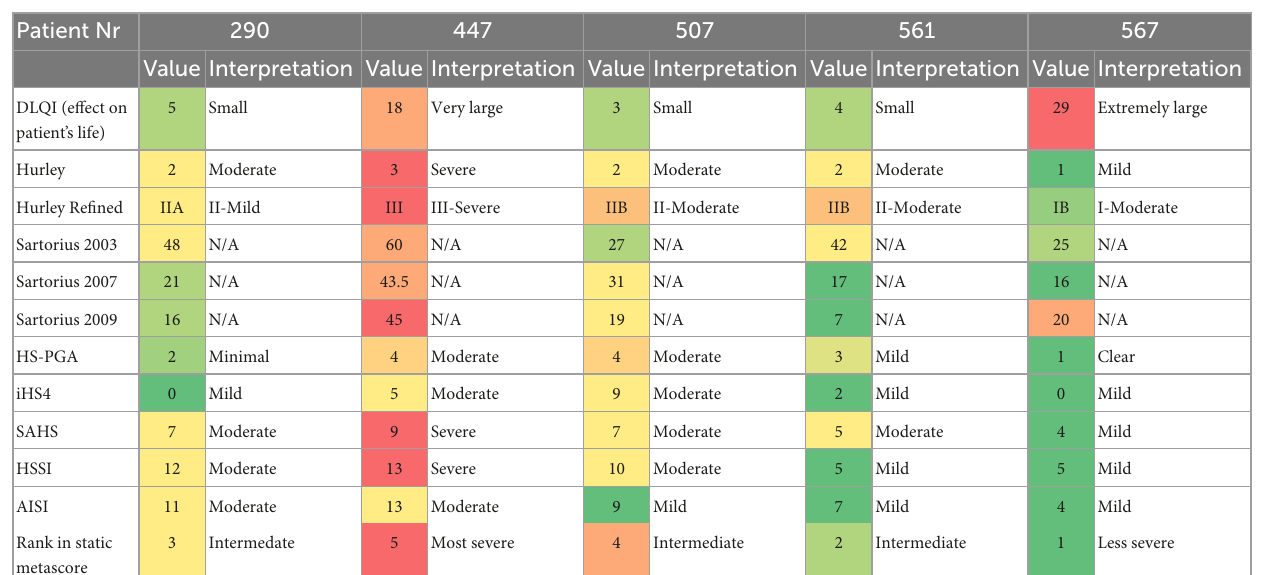
TABLE 1 Comparison of severity scores at a given